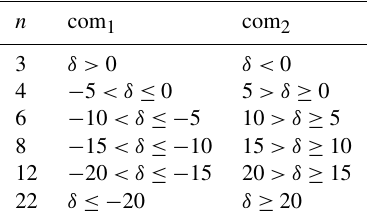
Table 1. Parameter n in Eqs. (2) and (3) as a function of solar dec- lination ( δ ).